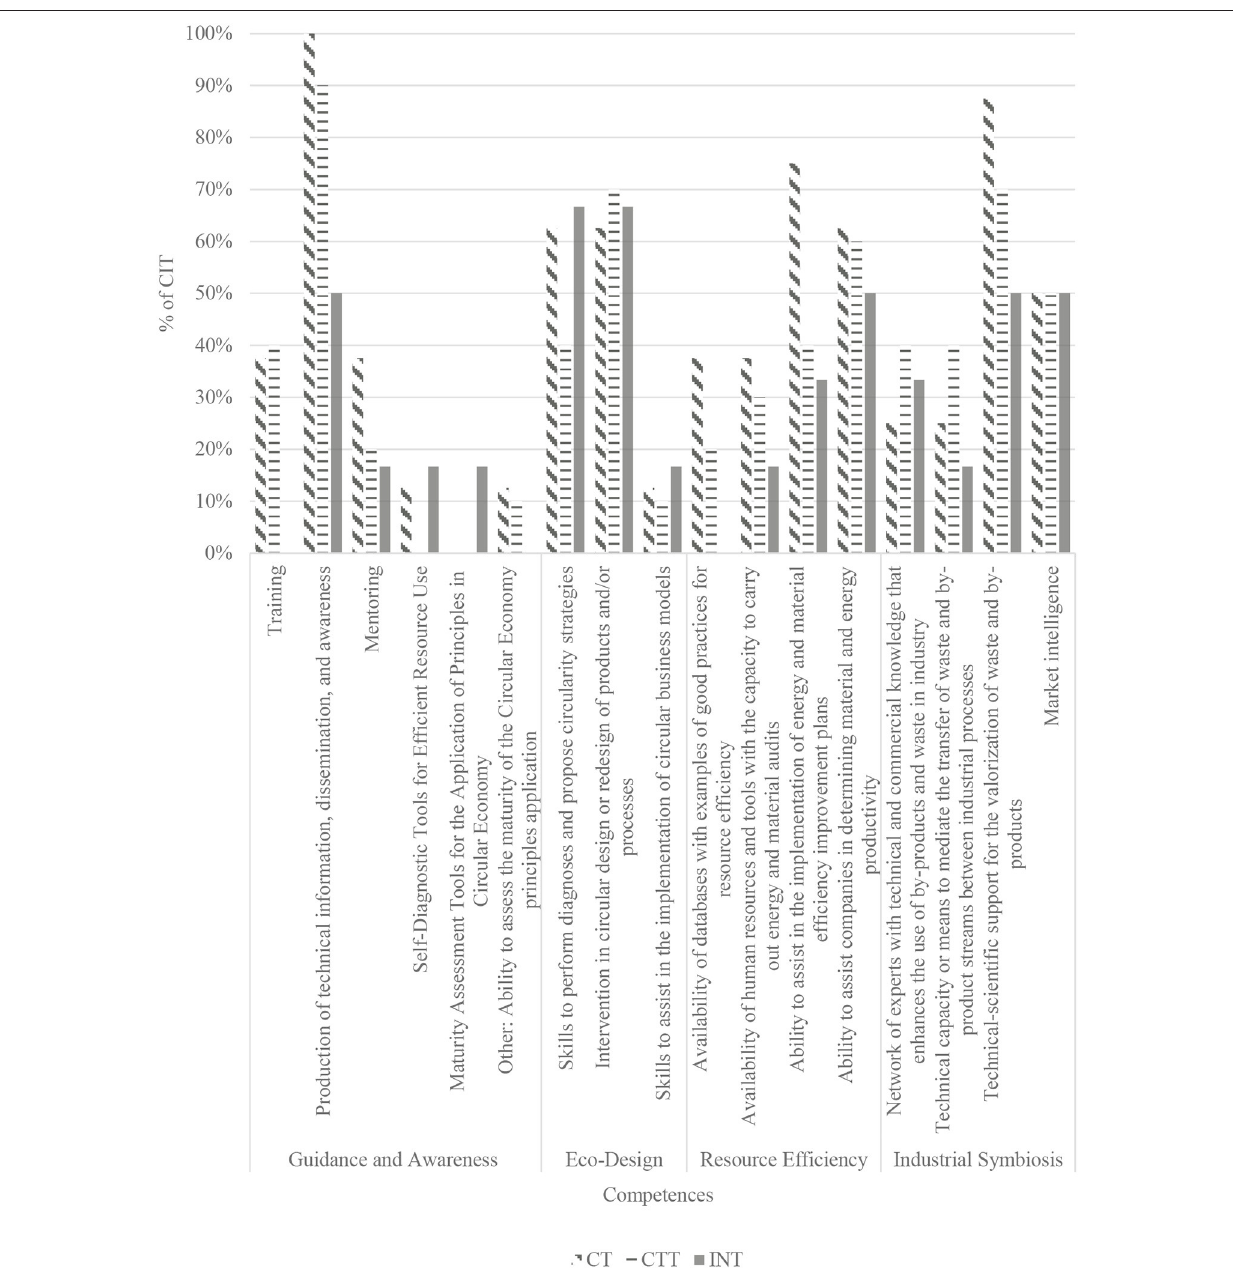
FIGURE 4 | Competences by group of technological interface